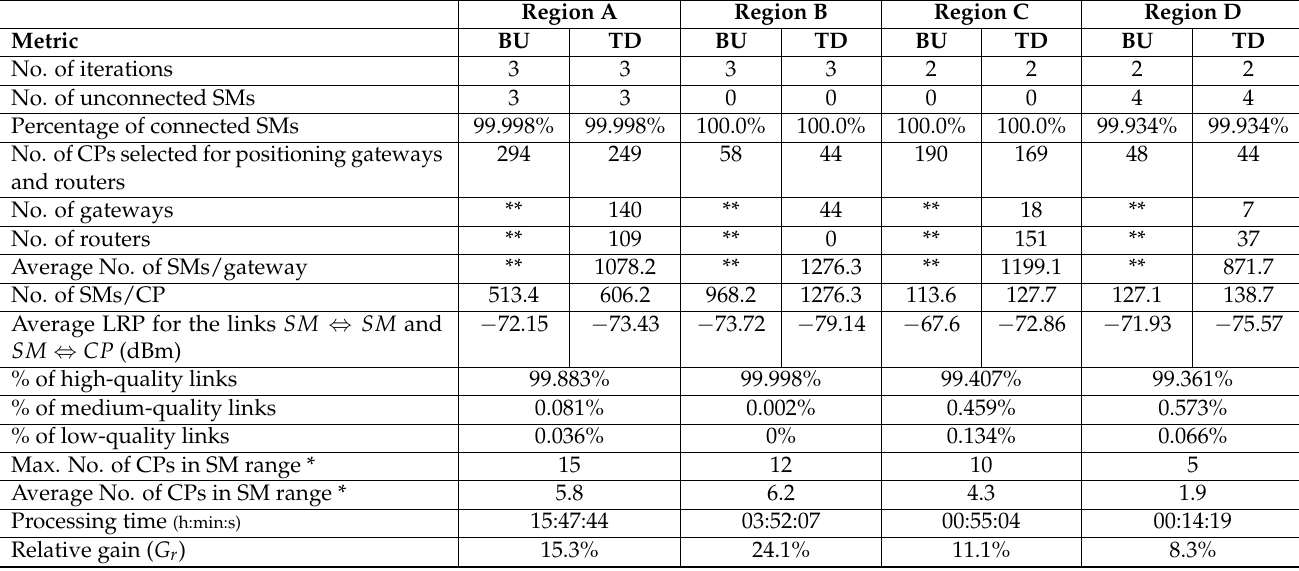
Figure 7. AIDA iterations for Region A. Table 6. Final results comparing bottom–up (BU) and top–down (TD)